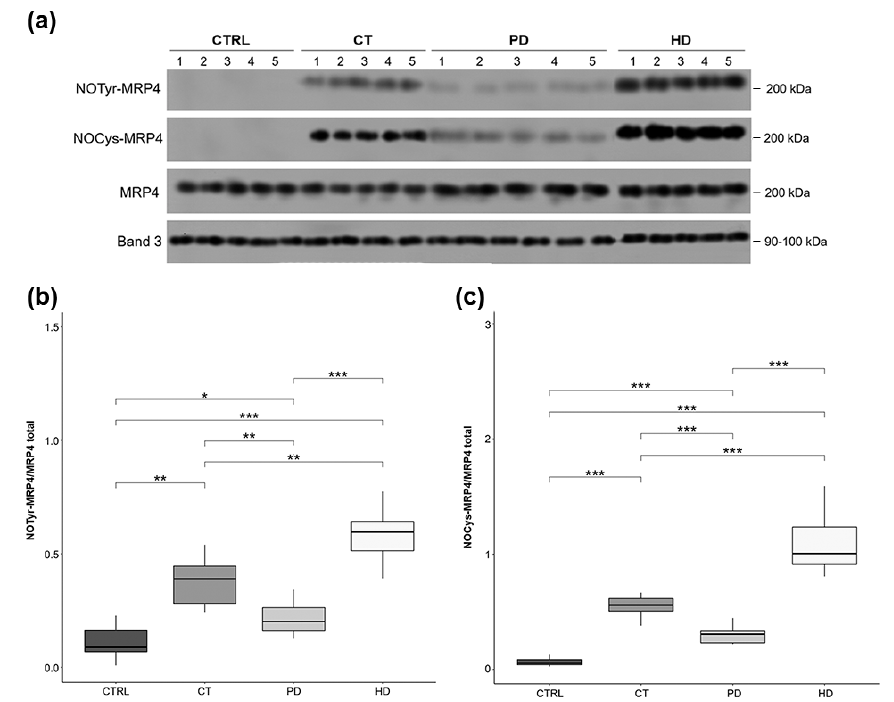
Figure 3. MRP4 nitration and nitrosylation levels in RBCs. ( a ) Representative Western Blot of membrane extracts obtained from all the study groups (CTRL, CT, PD, HD; N = 10 for each group). Band 3 was used as positive control of equal proteins loading. Box plots representing ( b ) MRP4 nitration (NOTyr-MRP4) and ( c ) nitrosylation (NOCys-MRP4) levels on MRP4 total. Horizontal black lines indicate the medians, boxes the interquartile range (IQR) and the bottom and top whiskers represent the minimum and maximum values. (* p < 0.05; ** p < 0.01; *** p < 0.001).